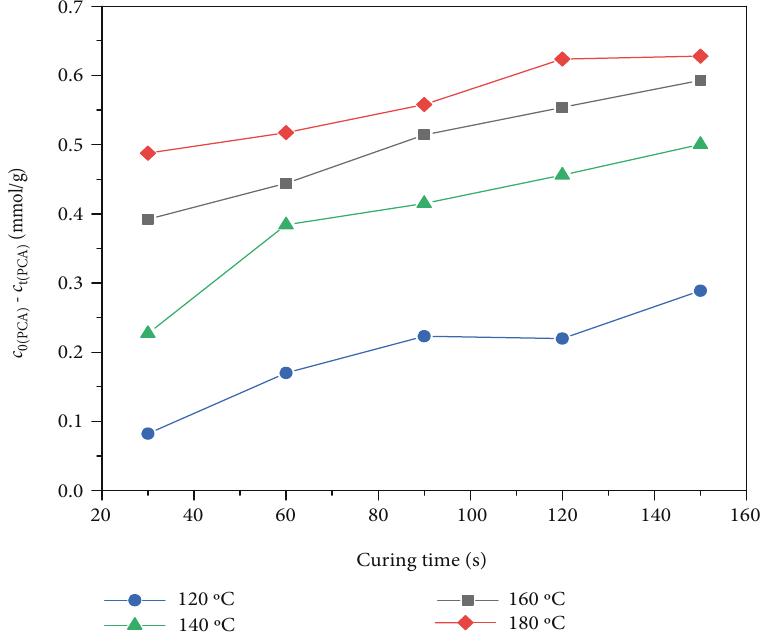
Figure 2: E ff ect of curing time on the consumption of carboxylic acids in the BTCA/CA fi nishing